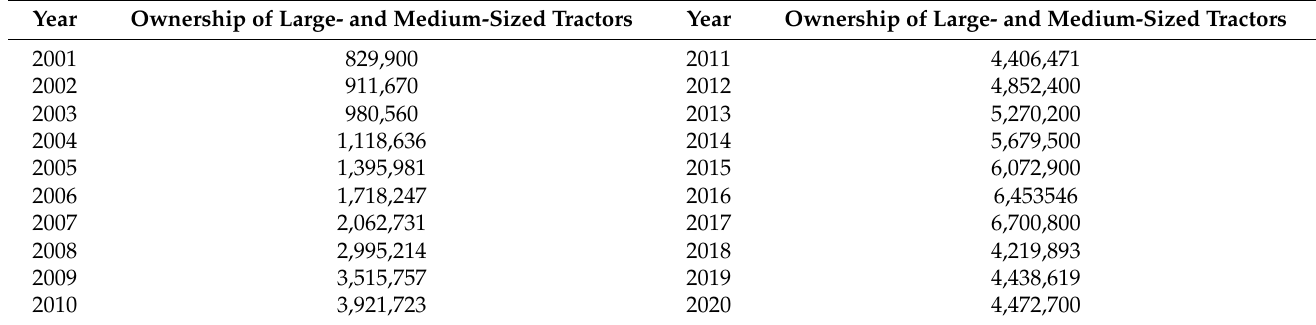
Table 2. Ownership of large- and medium-sized tractors in China from 2001 to